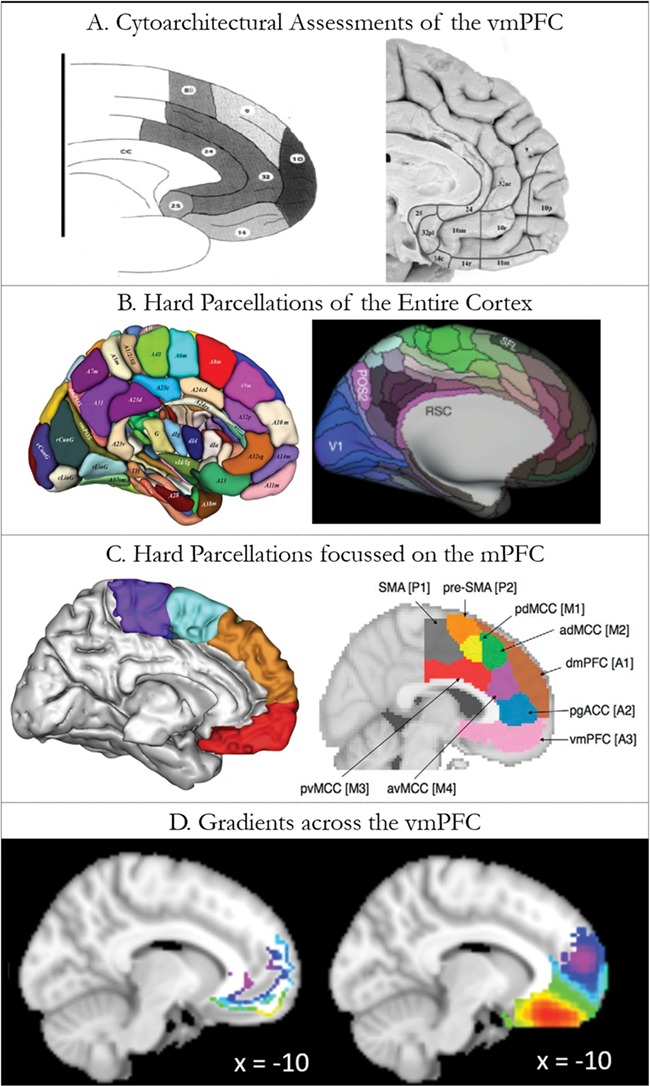
A diagrammatic review of some of the key literature on divisions within the vmPFC. A. The cytoarchitectural divisions within the vmPFC. Öngür et al. (2003) displayed the divisions discovered in Petrides & Pandya (1994; left) and their own updated divisions (on the right; Öngür et al. (2003). B. Recent hard parcellations of the entire cortex. The left panel shows Fan et al.’s (2016) division based on multimodal imaging techniques and the right panel displays Glasser et al.’s (2016) multimodal parcellation. C. Hard parcellations focussed on the mPFC. The left panel is Thiebaut de Schotten et al.’s (2016) tractographic parcellation and the right shows De la Vega et al.’s (2016) 9-cluster solution based on functional co-activation. The labels are from the original diagram. D. The current findings are provided for comparison. The left shows the structural connectivity gradient and the right shows the functional connectivity gradient. Figures are reproduced with permission from the copyright holders.